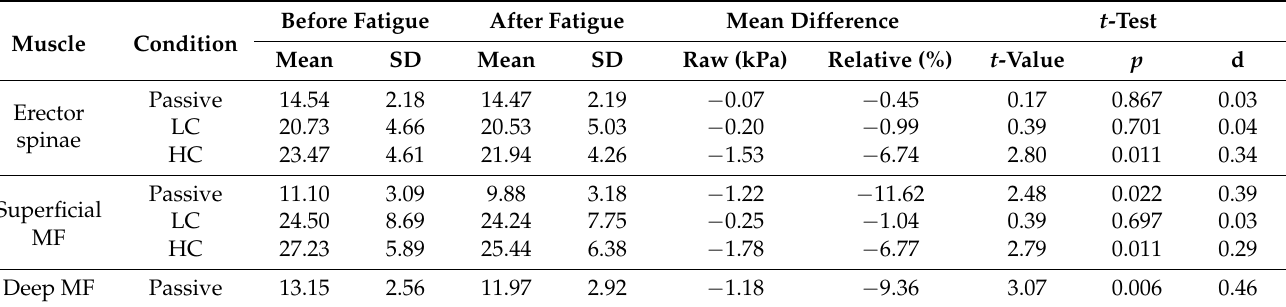
Table 1. The comparison of shear modulus scores before and after the fatiguing